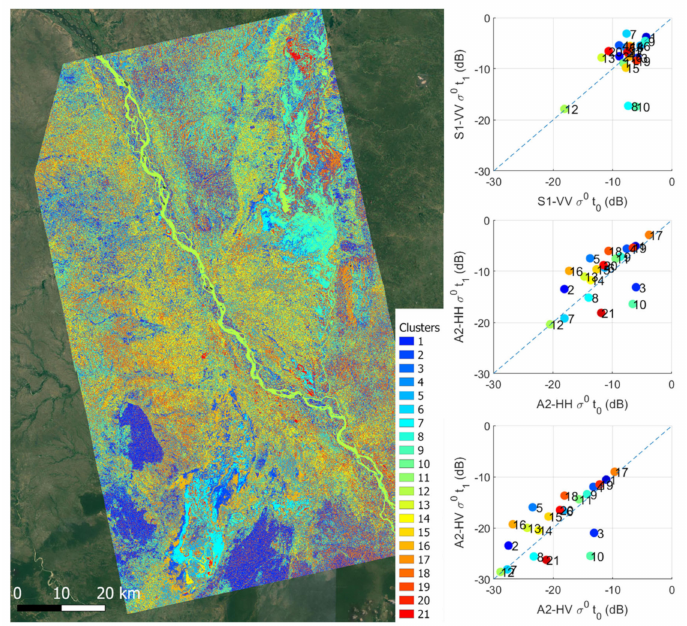
Figure 8. Left : K-means cluster map obtained with K = 21 clusters. Right : the three scatterplots show the cluster centers in the 3 planes whose axes are the 3 channels backscatter values in the pre- and flood acquisition dates. Cluster numbers are reported next to each colored dot to facilitate recognition in the legend and thus in the map.